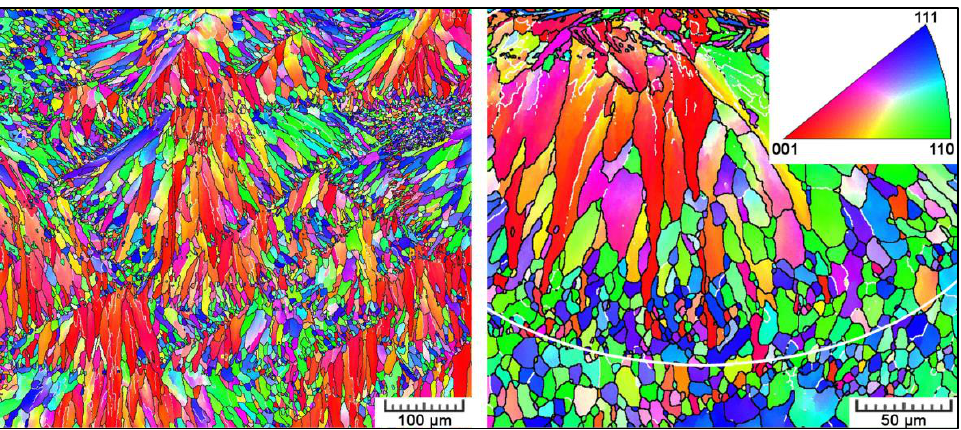
Figure 3. IPF maps constructed for fcc α-Al phase with the orientation triangle corresponding to the building direction (high-angle boundaries in black, low-angle boundaries in white). White line indicates the melt pool boundary.